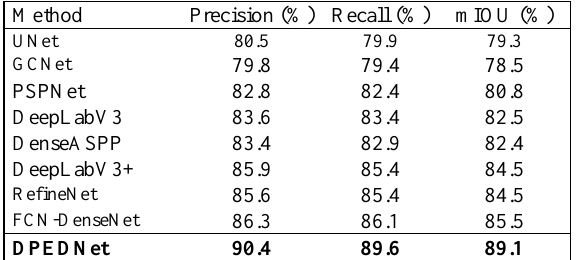
Table 4. Evaluation results on the Crowded mapping challenge validation set by using the model trained by single channel